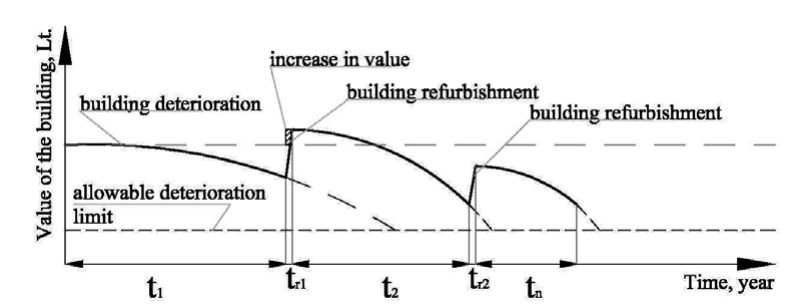
Figure 2. Building depreciation